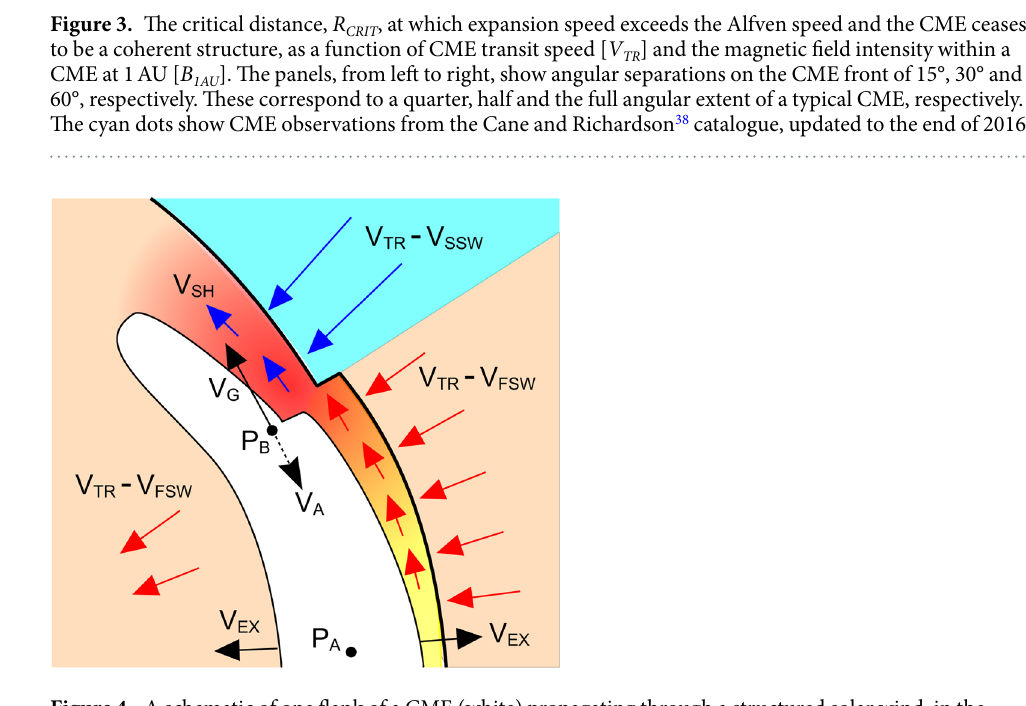
Figure 4. A schematic of one flank of a CME (white) propagating through a structured solar wind, in the reference frame of a point P A , located close to the centre of the CME. The shock (thick black line), and CME leading/trailing edges move away from P A at the CME expansion speed, V EX . Fast solar wind, in beige, flows into the CME shock at a speed V TR + V EX − V FSW ( V TR and V FSW are the CME transit speed and the fast solar wind speed, respectively). Slow solar wind, in blue, flows into the shock at a speed of V TR + V EX − V SSW , (where V SSW is the slow solar wind speed). The point P B , located at the fast/slow solar wind interface, experiences a distortion of the CME magnetic field and launches an Alfven wave at speed V A towards P A . Point P B , however, is moving away from P A due to geometric expansion at a speed V G , thus the information can never arrive. Similarly, V SH , the speed of the deflected solar wind flow in the sheath behind the shock, is smaller than V G and thus the sheath flow cannot travel around the